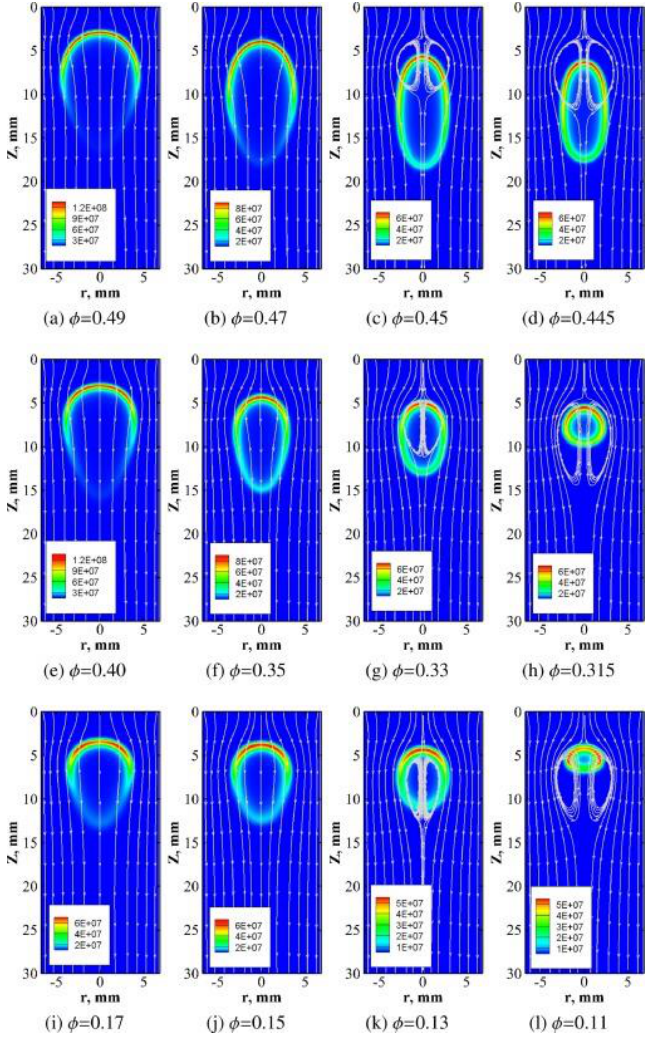
Figure 12. Distribution of chemical heat release rate (W / m 3 ) and flow streamlines for the flames studied in the simulations with a mixture-averaged transport model and skeletal mechanism at different fuel compositions ( a – d ): CH 4 -air, ( e – h ): CH 4 -H 2 , ( i – l ): H 2 [22].